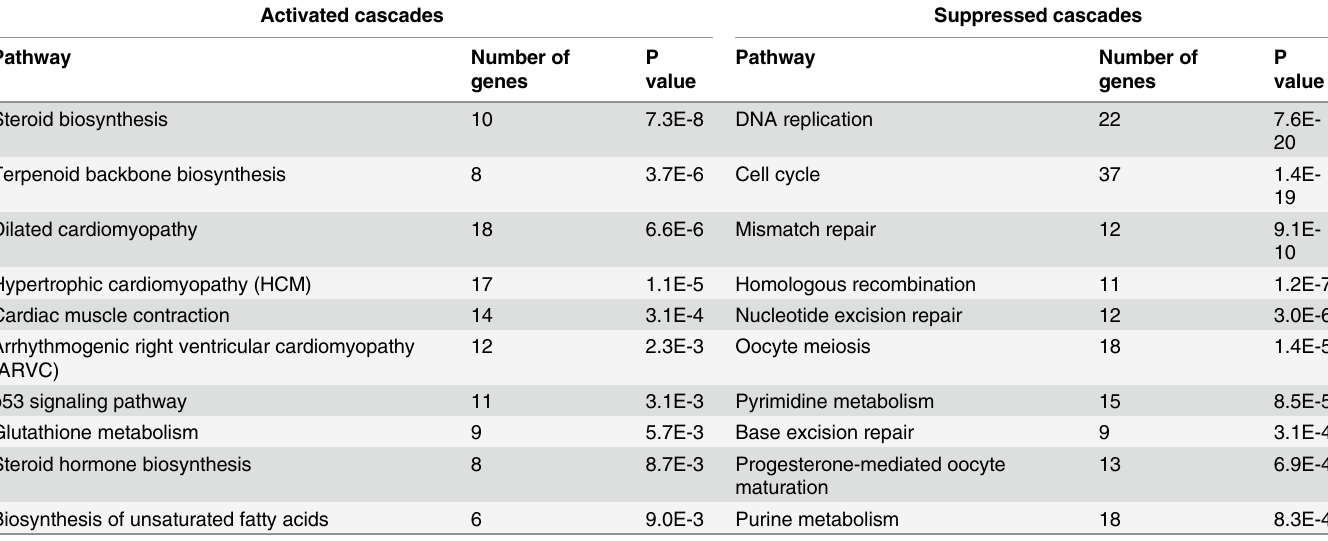
Table 1. Metabolic and signaling pathways represented by the alternatively expressed gene transcripts in RA-differentiated